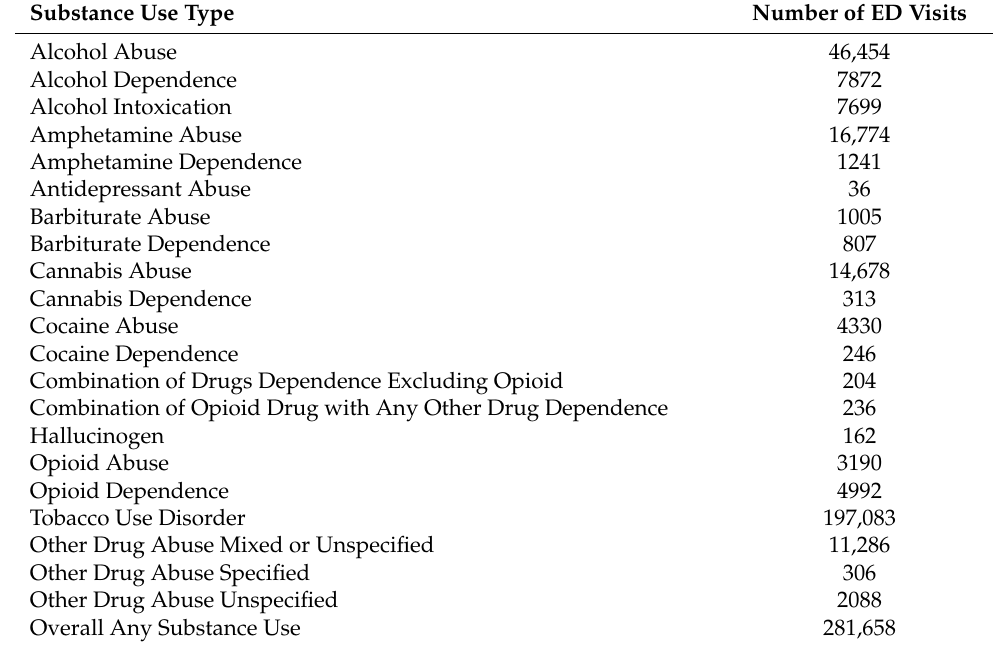
Table 2. Visits for Substance Use Categories: HCUP Emergency Department Visits Database for Hawaii,